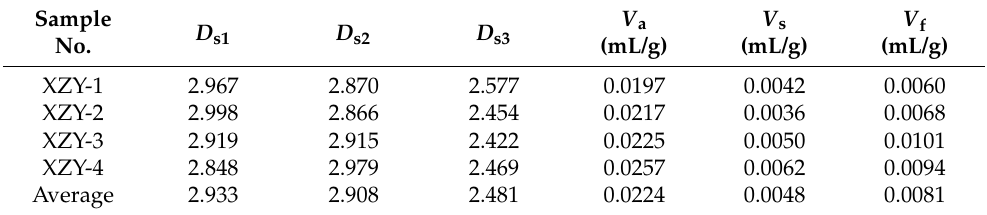
Table 4. The results of pore fractal dimensions of coal